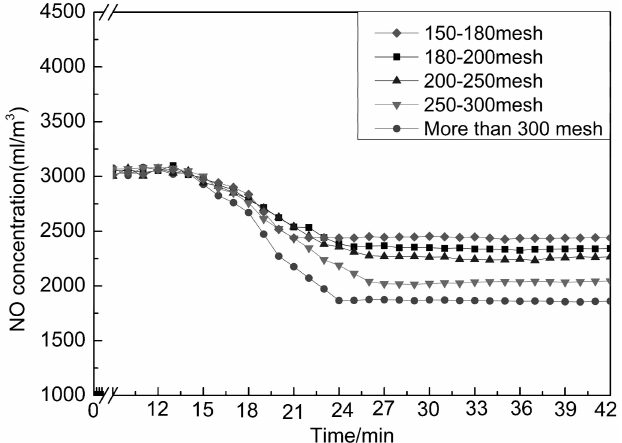
Figure 4. Relationship between the particle size and denitrification rate of primary